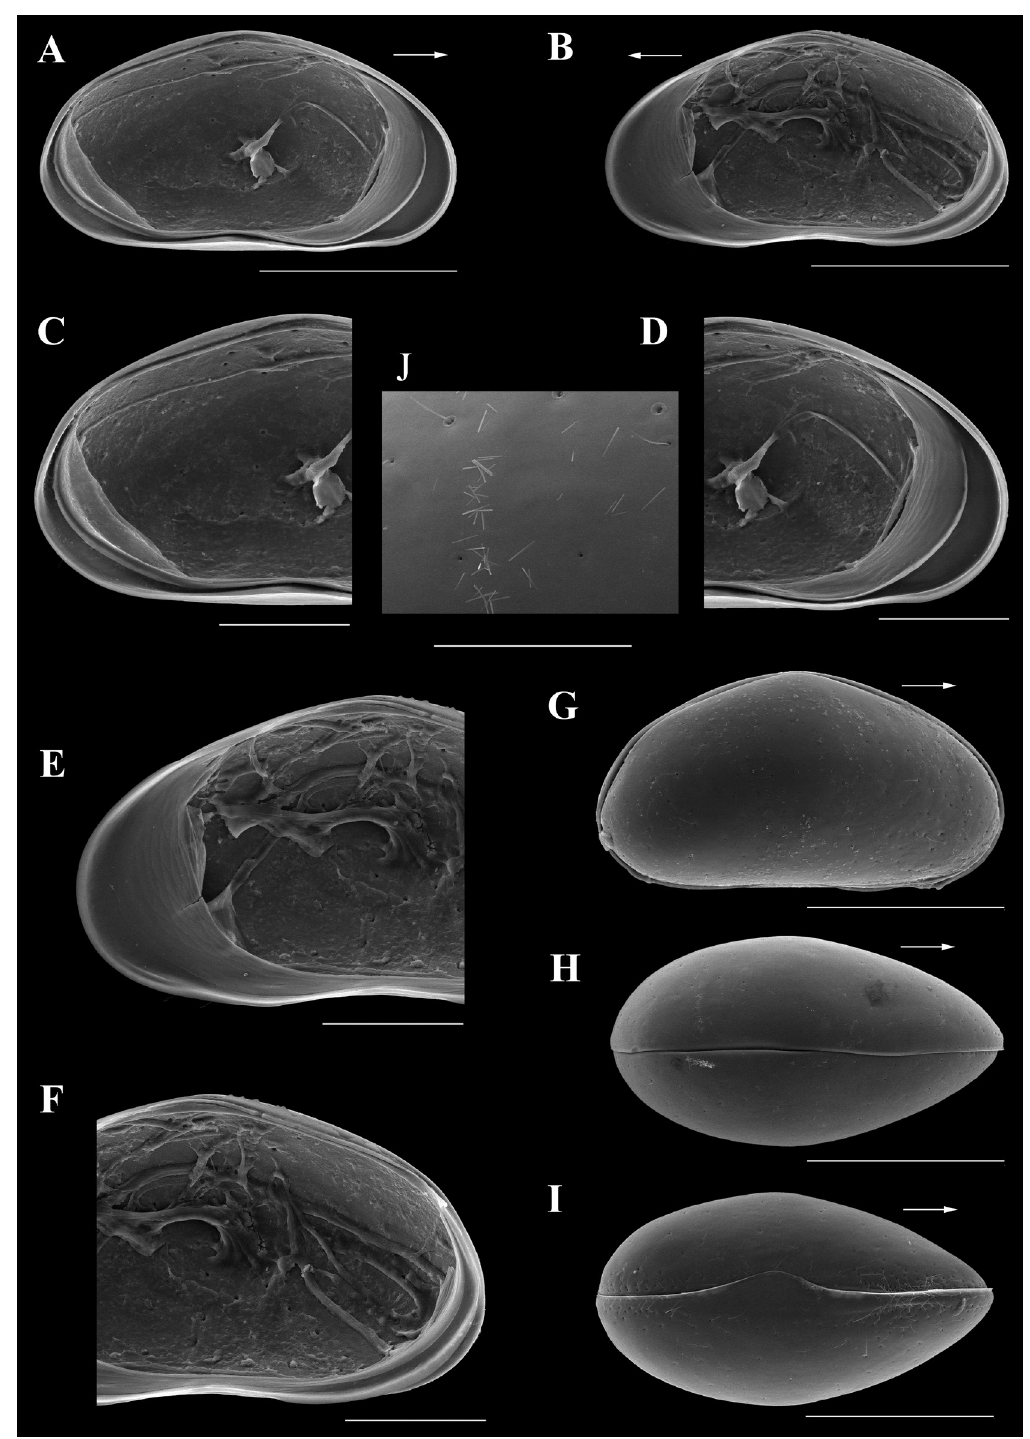
Fig. 3. Brasilodopsis baiabonita gen. et sp. nov. from Bonito, State of Mato Grosso do Sul, ♂. A . LVi (MZUSP 41836). B . RVi (MZUSP 41836). C . LVi, detail of posterior part (MZUSP 41836). D . LVi, detail of anterior part (MZUSP 41836). E . RVi, detail of anterior part (MZUSP 41836). F . RVi, detail of posterior part (MZUSP 41836). G . CpRl (MZUSP 41837). H . CpD (MZUSP 41838). I . CpV (MZUSP 41839). J . CpD, detail of pores and setae (MZUSP 41838). Scale bars: A–B, G–I = 300 µm; C–F = 100 µm; J = 50